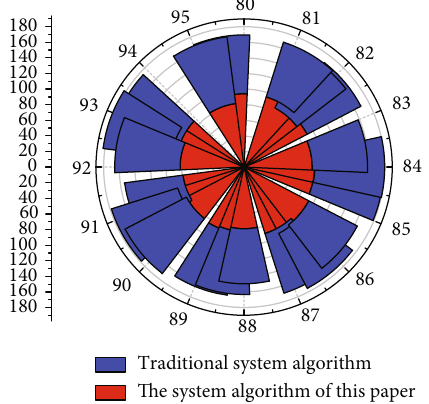
Figure 8: Face recognition experiment